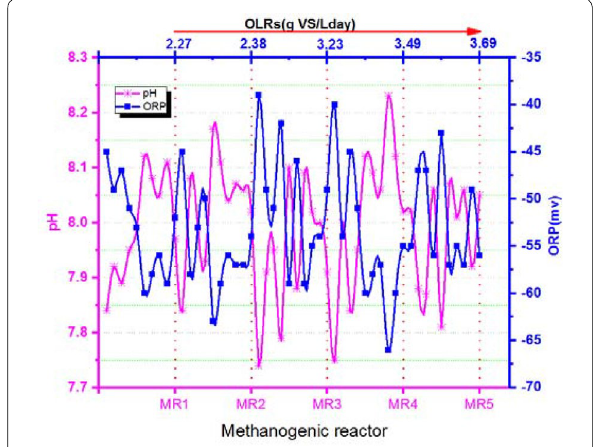
Fig. 7 Trends of pH and ORP in each